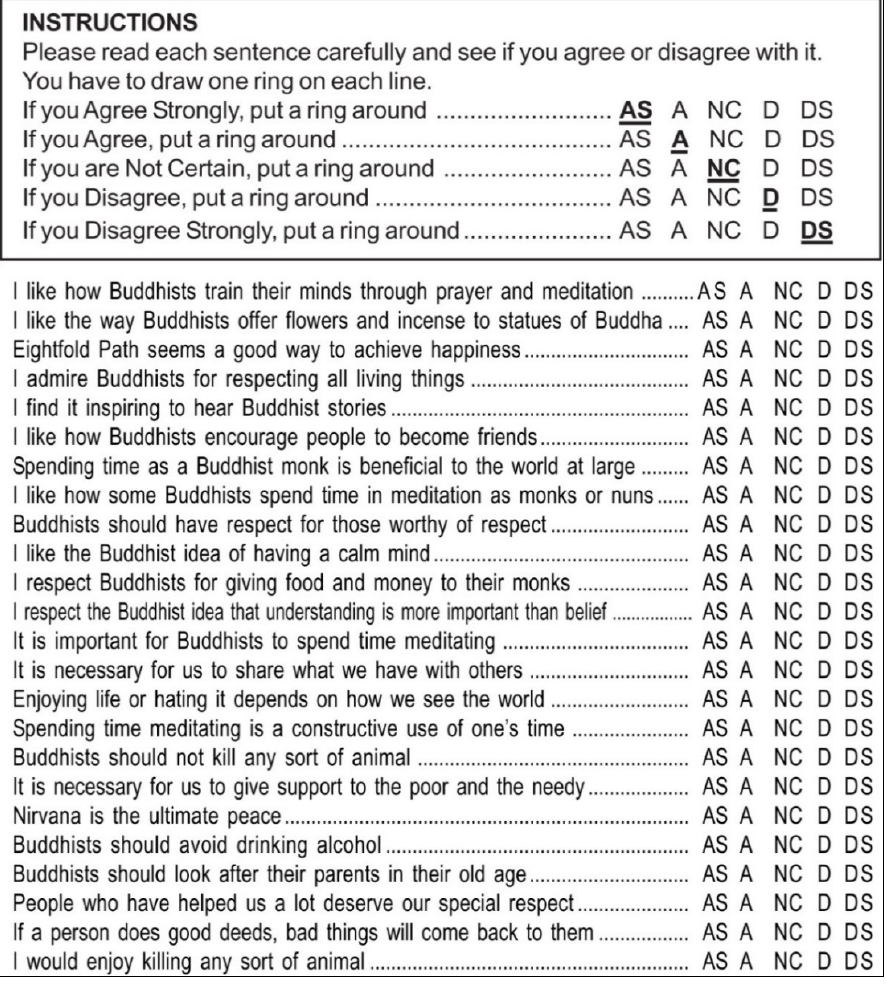
Figure A1. Revised Scale of Attitude towards Buddhism (TSAB ‐ R).